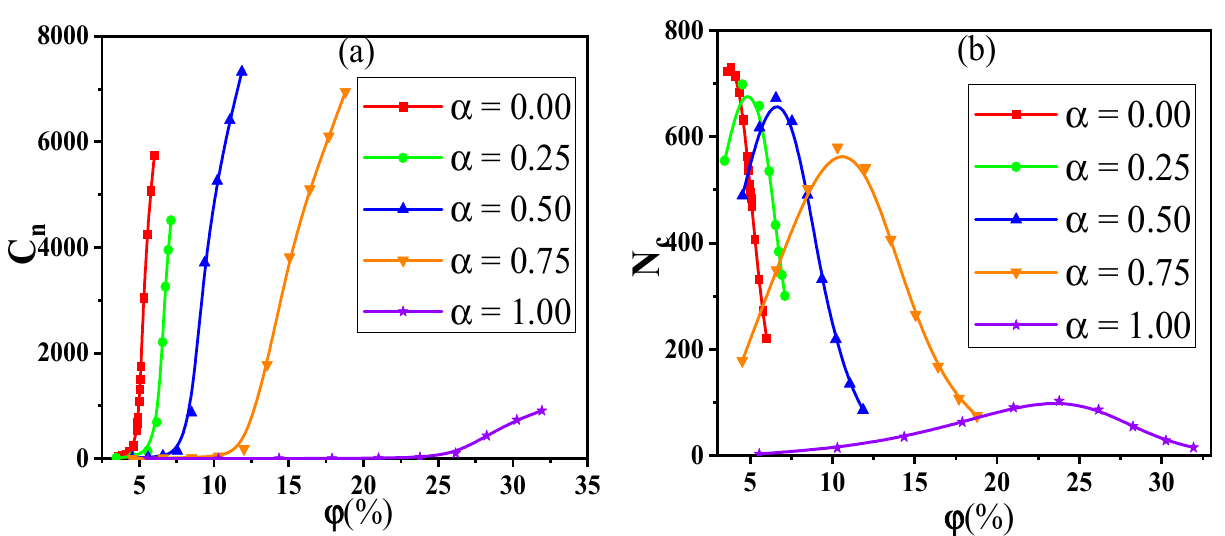
Figure 2. ( a ) The largest size C n and ( b ) the number N c of clusters with respect to the concentration ϕ of nanoparticles for various mixing ratios ( α ).